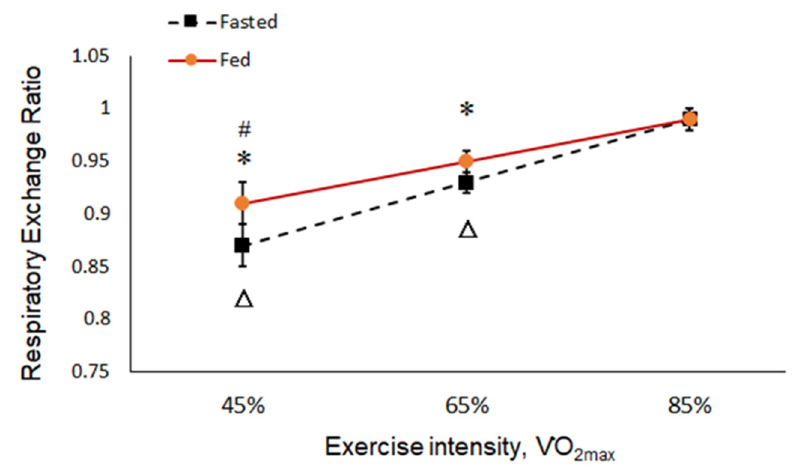
Figure 5. Respiratory exchange ratio (RER) at each intensity in the fed and fasted state. “*”: Significant difference compared to 85% VO 2max at 65% and 45% VO 2max in the same state ( p < 0.05). “ △ ”: Significant difference between the fed and fasted state at the same exercise intensity ( p < 0.05). “#”: Significant difference compared to 65% VO 2max at 45% VO 2max in the same state ( p < 0.05).